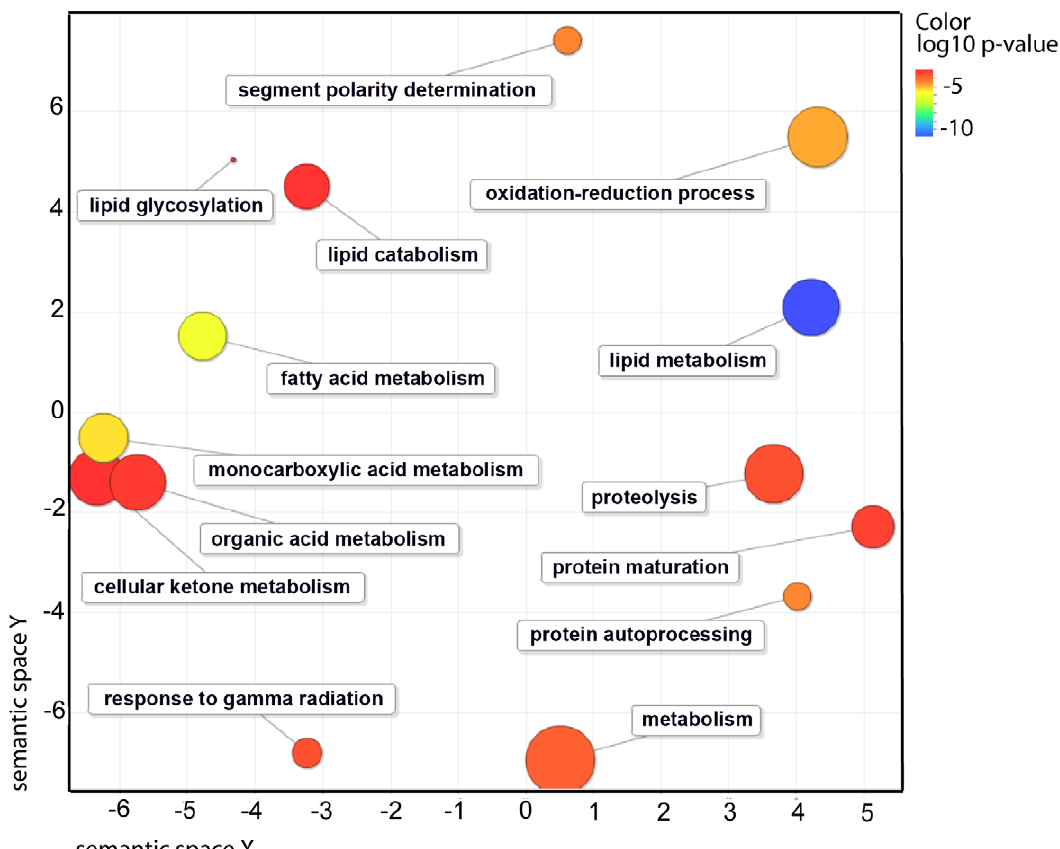
Figure 2. Functional classification summary for the nhr-49 mutant are represented as a scatter plot using the GO visualization tool REViGO. X- and Y-axes represent a two-dimensional annotation space derived from a multi-dimensional scaling procedure used on a matrix of GO terms’ semantic similarities (see reference 51 for details). By employing this visualization method, similar functional categories will cluster together. Bubble color represents the p-value obtained from GO term enrichment analysis (GOrilla, see Materials and Methods) and bubble size relates to the frequency of GO terms in the Gene Ontology Annotation Database.